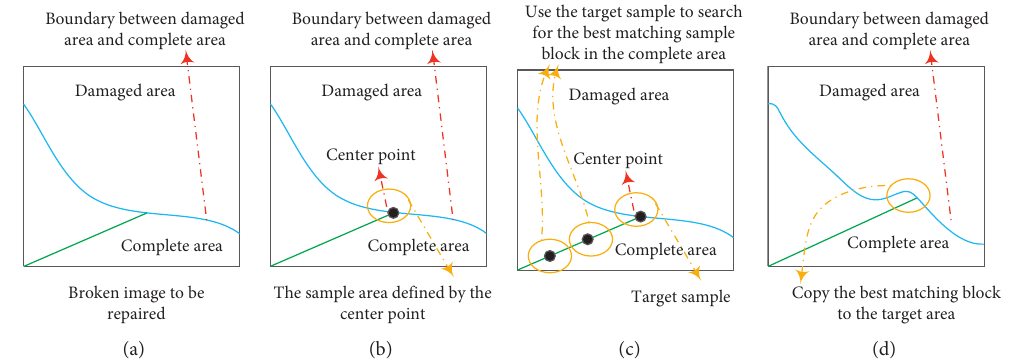
Figure 2: Schematic diagram of Criminisi algorithm repair.